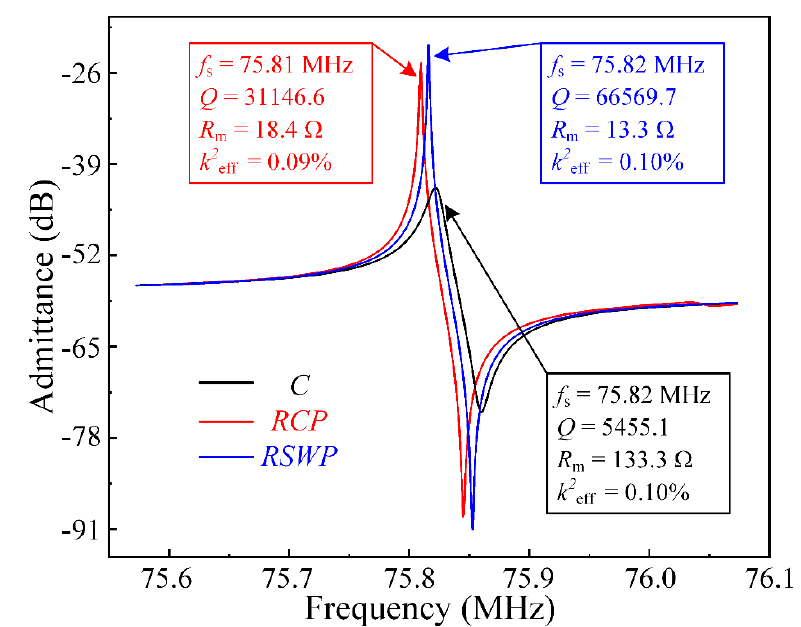
Figure 9. Illustration of the admittance spectra for resonators C, RCP, and RSWP in the same frequency range. The simulated results of admittance curves are well consistent with the transmission characteristics, verifying that the SW-PnC can sufficiently reduce the energy dissipation of resonators, thereby achieving the optimal Q .